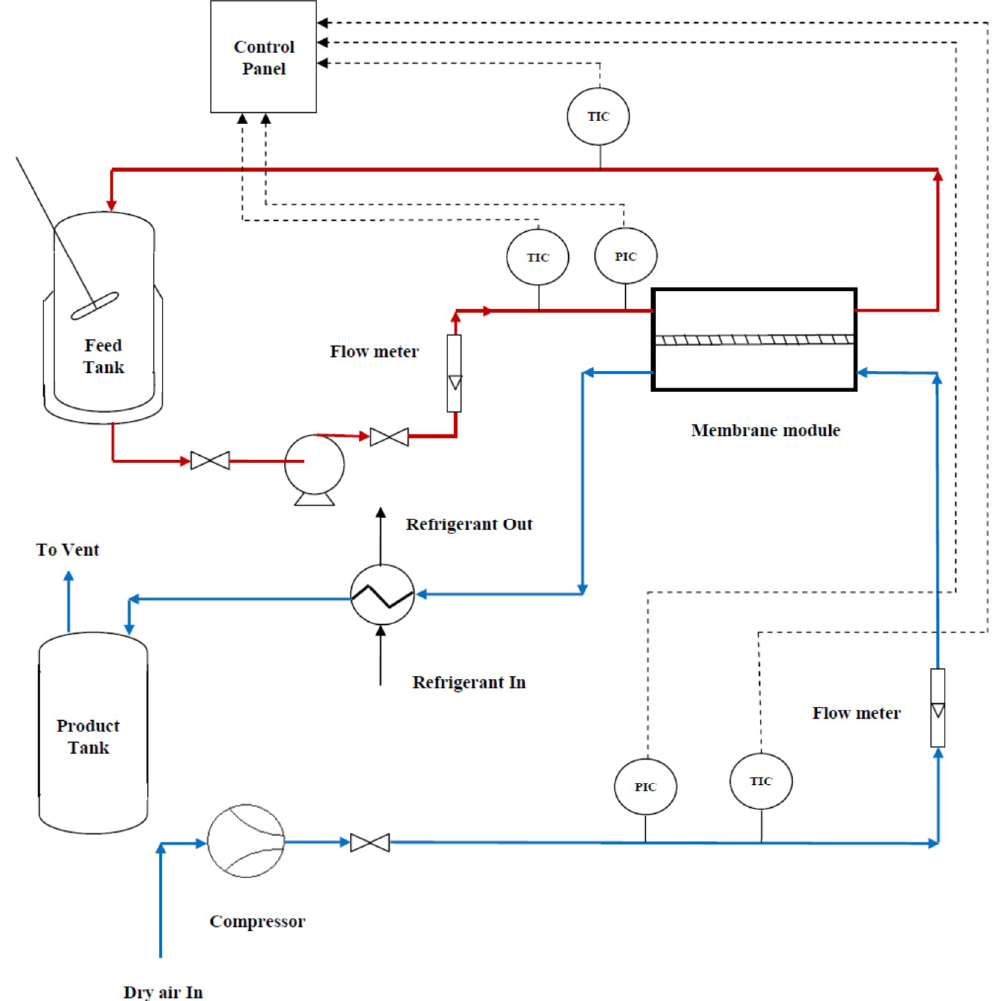
Figure 1. The general scheme of the experimental sweeping gas membrane distillation (SGMD) setup. The system includes the hot side (with red lines): a jacket tank equipped with an over-head mixer and a Pt-100 thermal sensor, a diaphragm pump for recirculation of the feed, flowmeter, the SGMD module equipped with a polytetrafluoroethylene (PTFE) (0.22 µm) membrane and four Pt-100 thermal sensors for entrance and exit points; and the cold side (with blue lines): an oil-free compressor for proving the SG, a flow-meter for adjusting the SG flow, feed tank, and refrigerator system for condensing the permeate vapor.